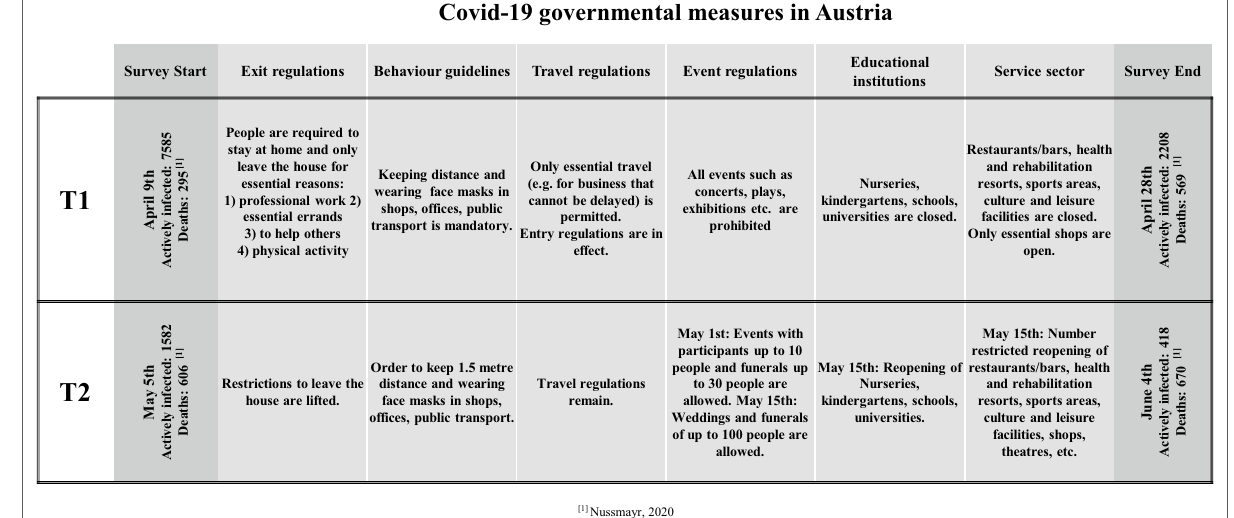
contacts except for people sharing the same household.